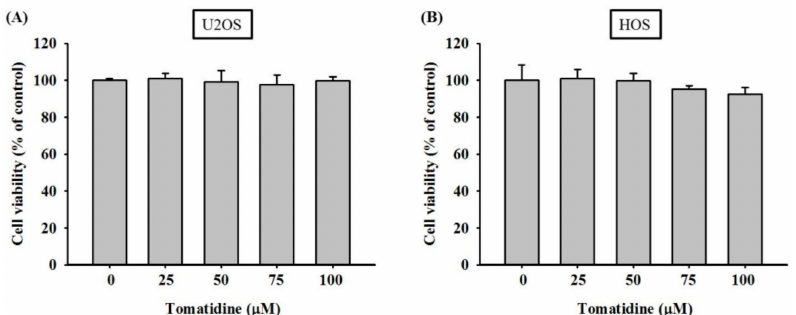
Figure 1. E ff ects of tomatidine on the cell viability of U2OS and HOS cells. ( A and B ) Using an Microculture Tetrazolium (MTT) assay, the e ff ects of tomatidine on the viability of U2OS and HOS cells treated with tomatidine (0–100 µ M) for 24 h were detected and illustrated after quantitative analysis. Results are shown as mean ± S.D. ANOVA analysis with Turkey’s posteriori comparison was used. (A) n = 3. F = 0.265, p = 0.894. (B) n = 4. F = 2.067, p =